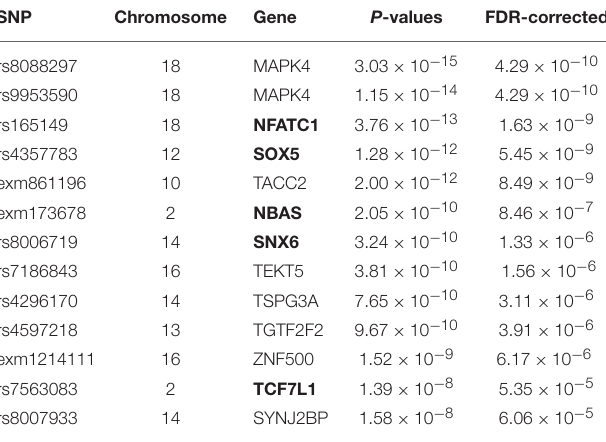
TABLE 1 | Top 13 significant SNPs associated with angle of surface orientation scores. SNP Chromosome Gene P